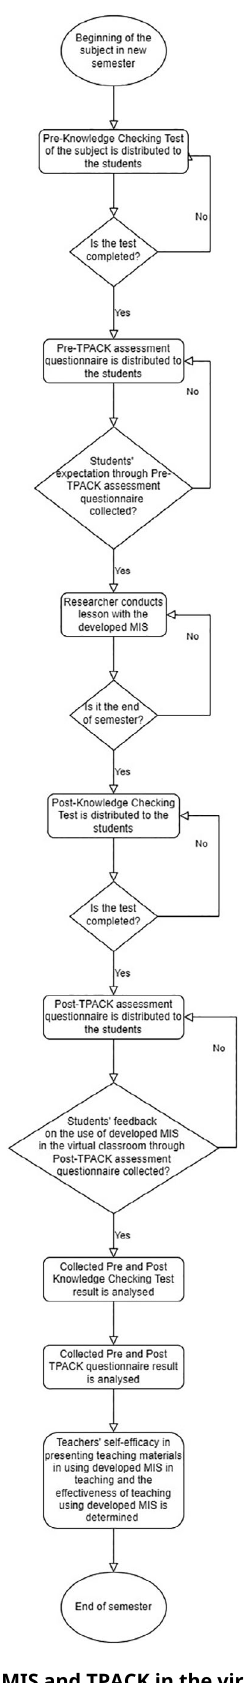
Figure 1. Flow chart of the integration of MIS and TPACK in the virtual